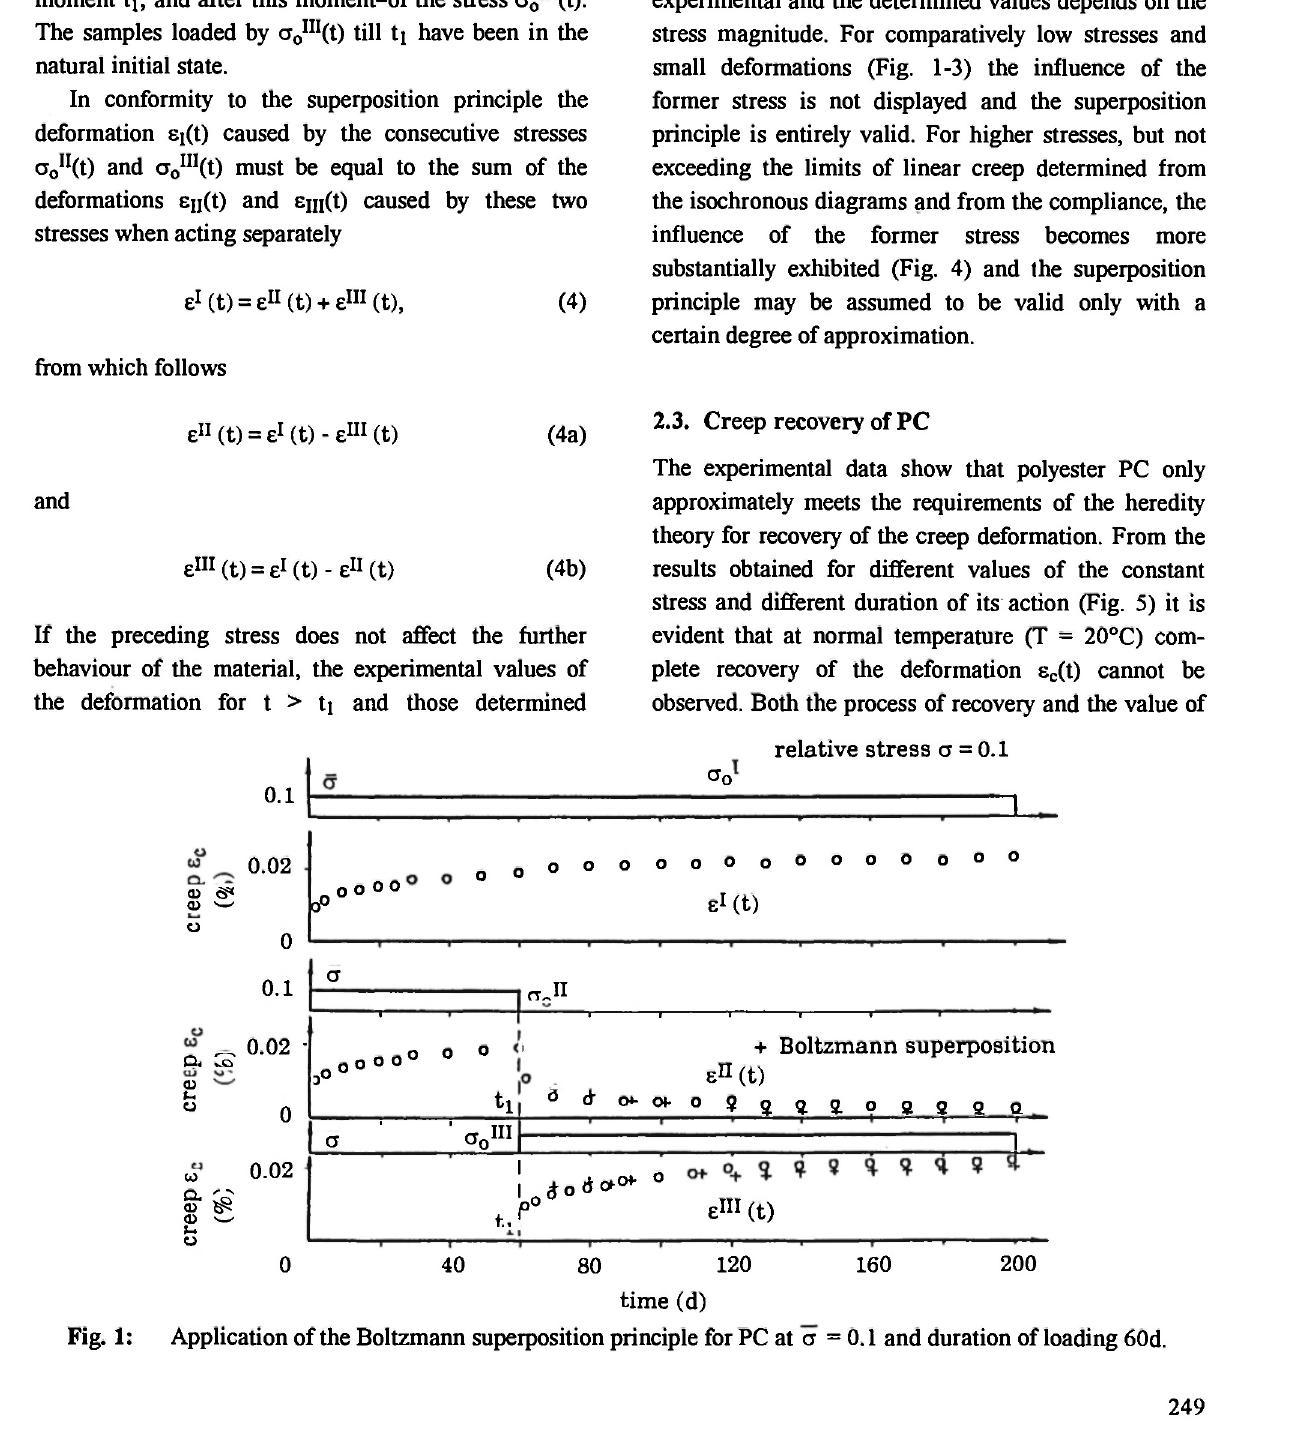
Fig. 1: Application of the Boltzmann superposition principle for PC at σ = 0.1 and duration of loading